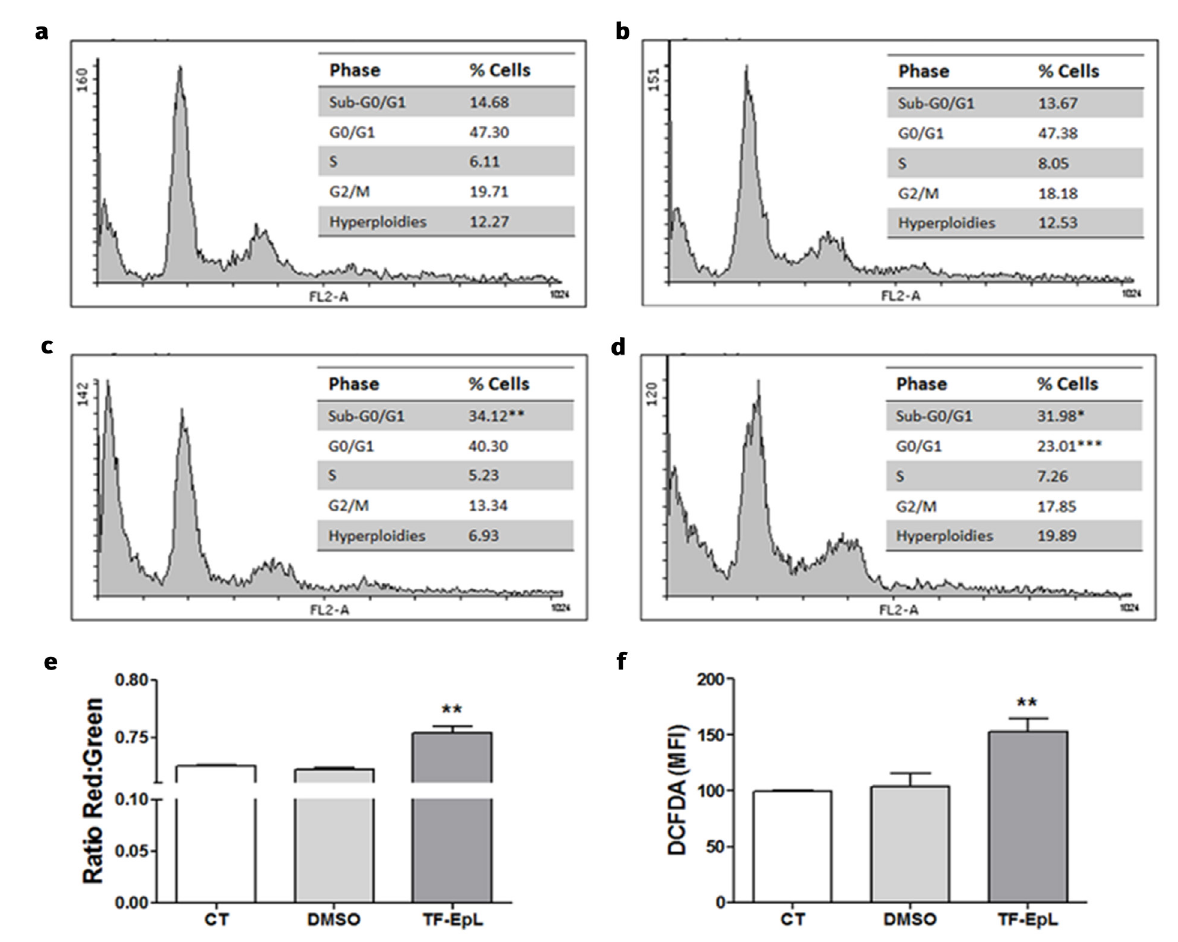
Figure 2. Evaluation of cell cycle, mitochondrial membrane potential (ΔΨm) and reactive oxygen species (ROS) production by Leishmania amazonensis promastigotes. Promastigotes were treated or not with TF-EpL and cell cycle was evaluated after 48h after PI staining by flow cytometry analysis. Untreated parasites control (a), 1 % DMSO (b), 43.60 μg / mL TF-EpL (c) and 0.1 μg/mL Amphotericin B (d). Representative plots of at least three independent experiments with similar results. (e) Promastigotes treated or not with 43.60 µg/mL TF-EpL was evaluated using a JC-1 assay. The results are expressed as red / green fluorescence ratios and represent the averages ± SEM from 3 independent experiments. (f) Promastigotes treated or not with 43.60 µg/mL TF-EpL or 1 % DMSO were then stained with 50 μM DCFDA and ROS was measured by flow cytometer. The results represent the means ± SEM from 3 experiments performed in triplicate. p < 0.05 (*), p < 0.001 (**), and p < 0.0001 (***) compared to the untreated of neutral hydrophobic domains (Fig. 4a) but do not alter the polar hydrophobic domains or phospholipids (Fig. 4b). The reduction of neutral lipid in TF-EpL treated parasites suggested either inhibition or a deviation in the lipidic synthesis pathway (Ferreira et al. 2011).